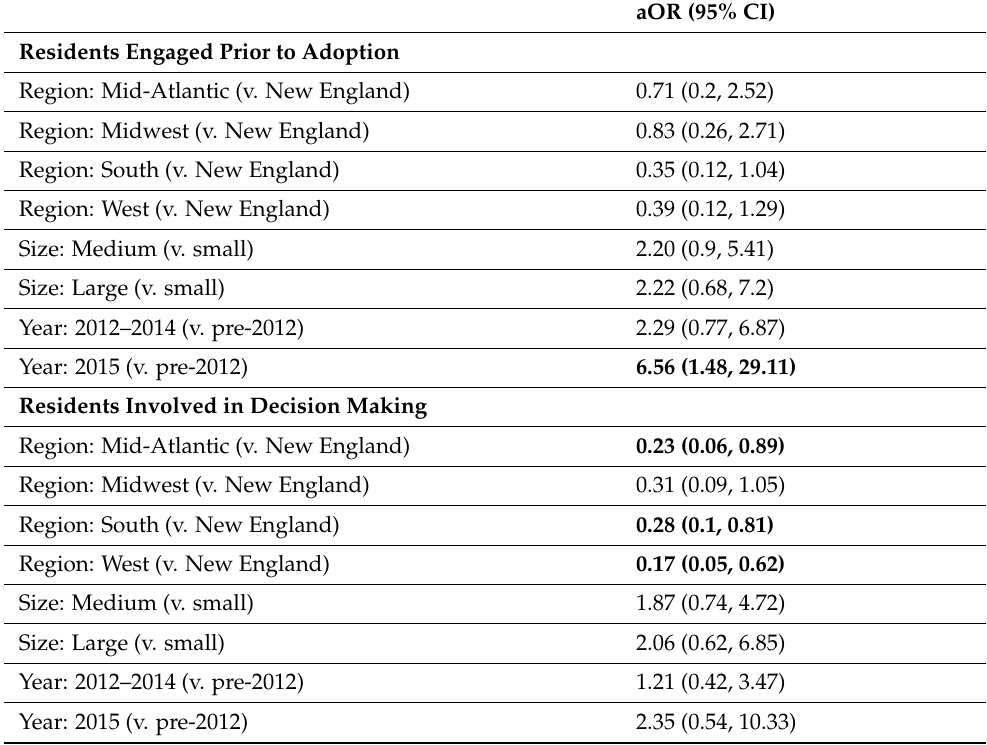
Table 4. Adjusted odds ratios (95% CI) of undertaking most/all specified implementation strategies, by size and year of adoption and